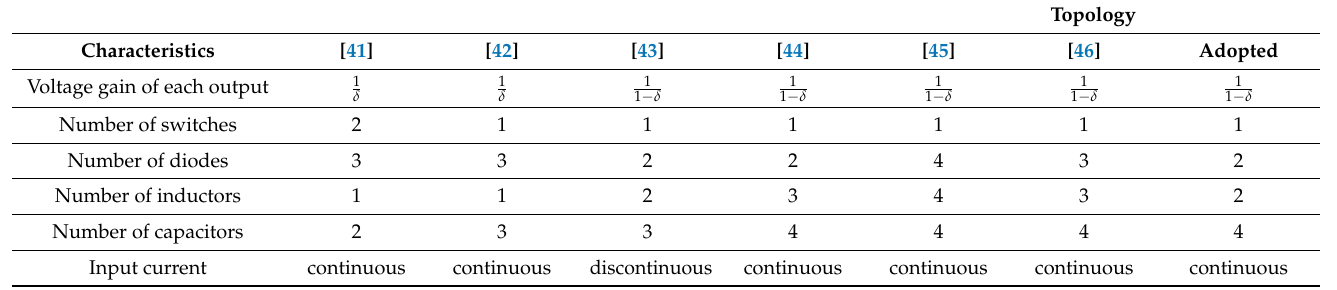
Table 3. Comparison with DC / DC power converters used between the PV panels and the SRM